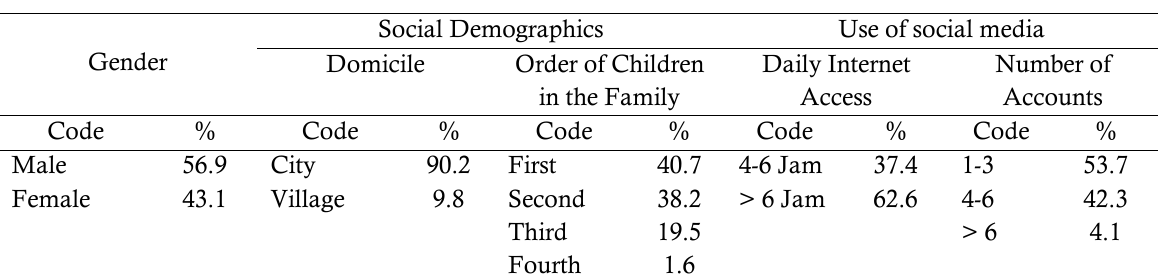
Table 1. Research Respondent Data